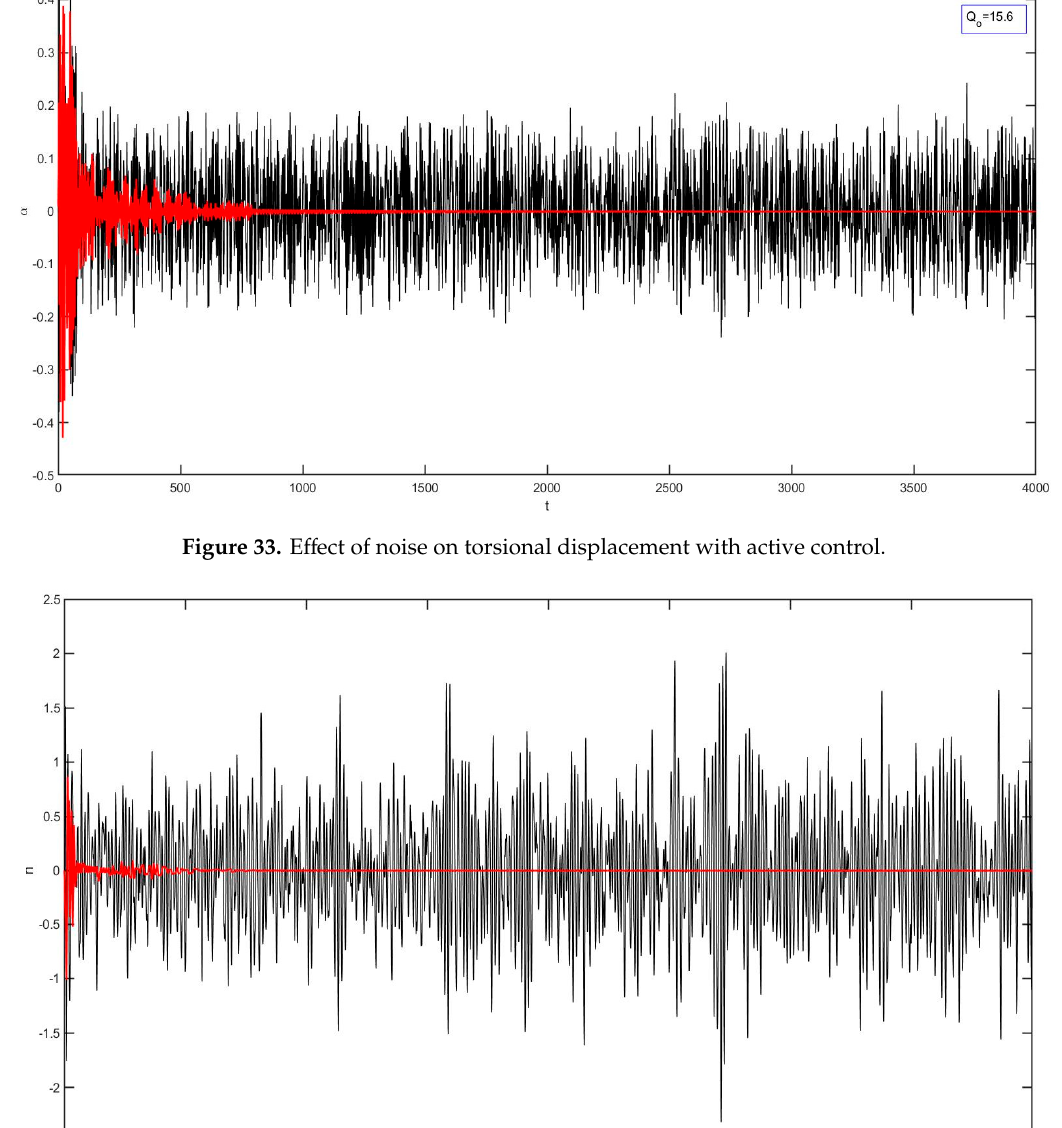
Figure 34. E ff ect of noise on bending displacement with active Figure 34. Effect of noise on bending displacement with active control.